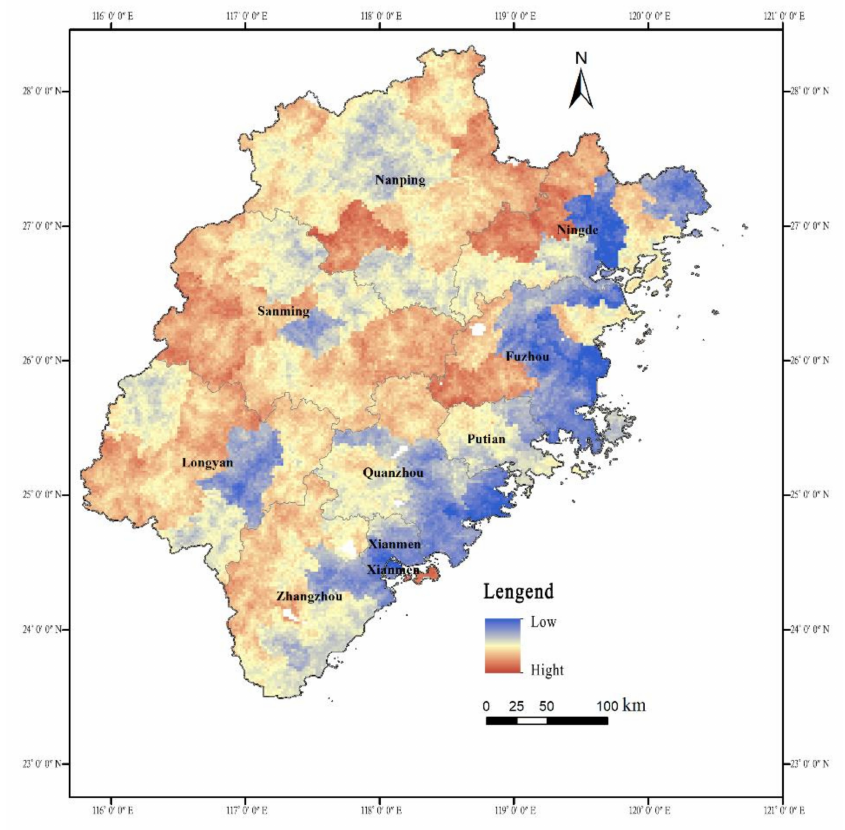
Figure 6. Grid map of suitability evaluation values of ethnic minority villages in Fujian